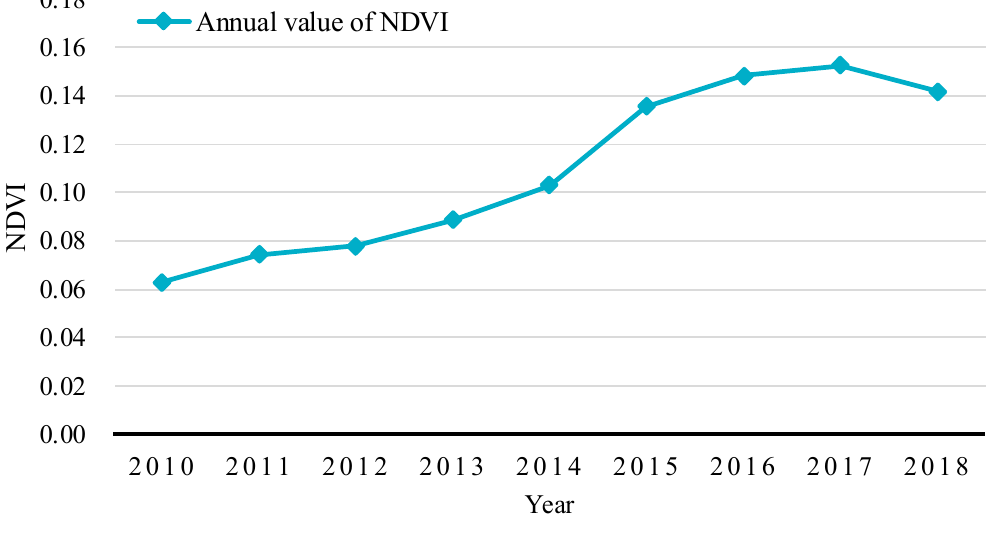
Figure 5. Change in vegetation coverage around Qingtu Lake from 2010 to 2018. NDVI: Normalized Vegetation Difference Index.